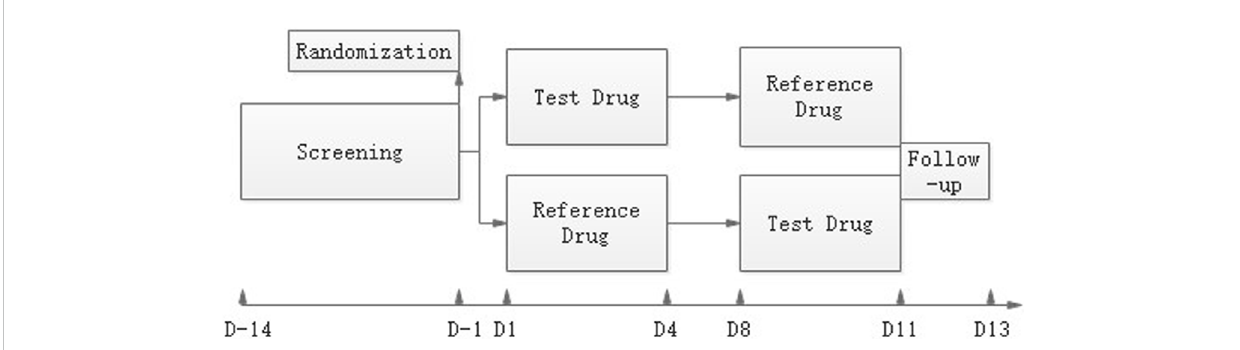
FIGURE 1 Study design. After a maximum screening of 14 days, eligible subjects were randomized on day-1. The reference drug JANUMET ® XR (sitagliptin 100 mg and metformin 1000 mg HCl extended-release) tablets or the test drug was given on day 1 or day 8 in a randomized R-T or T-R sequence, and serial PK samples were collected. A follow-up visit was done on